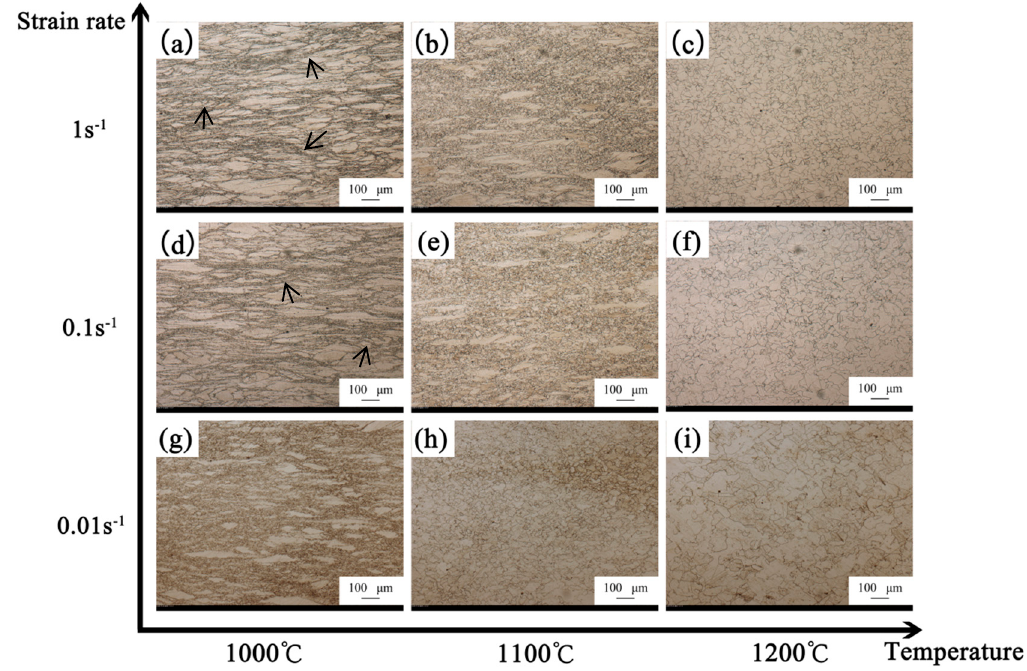
Figure 8. Effects of temperature and strain rate on microstructure of Nb-contained 316LN at strain of 0.8.